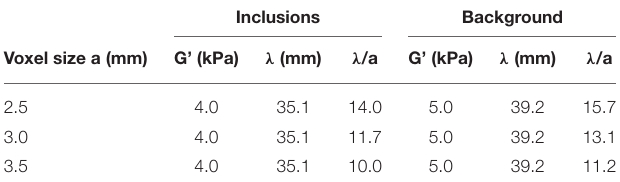
TABLE 2 | Simulated values of G’ in the inclusions and background with corresponding shear wavelength λ and the calculated ratio of wavelength to voxel size λ /a for the considered values of a .